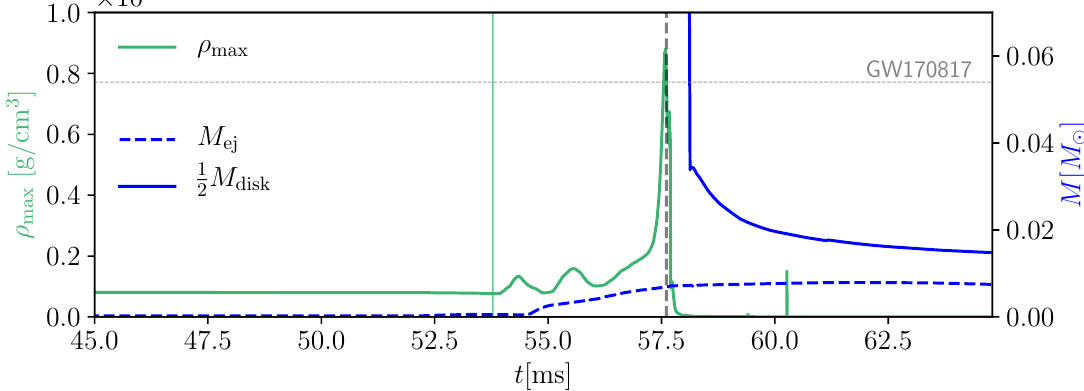
Figure 7. Time evolution of the maximum density (green) and the amount of ejected material (dashed blue) and the disk mass (solid blue) for resolution R3. The ejected material is estimated according to Equations (14) and (15) of Reference [52], that is, all material is marked as ejecta as long as it is gravitationally unbound and has an outward pointing velocity.